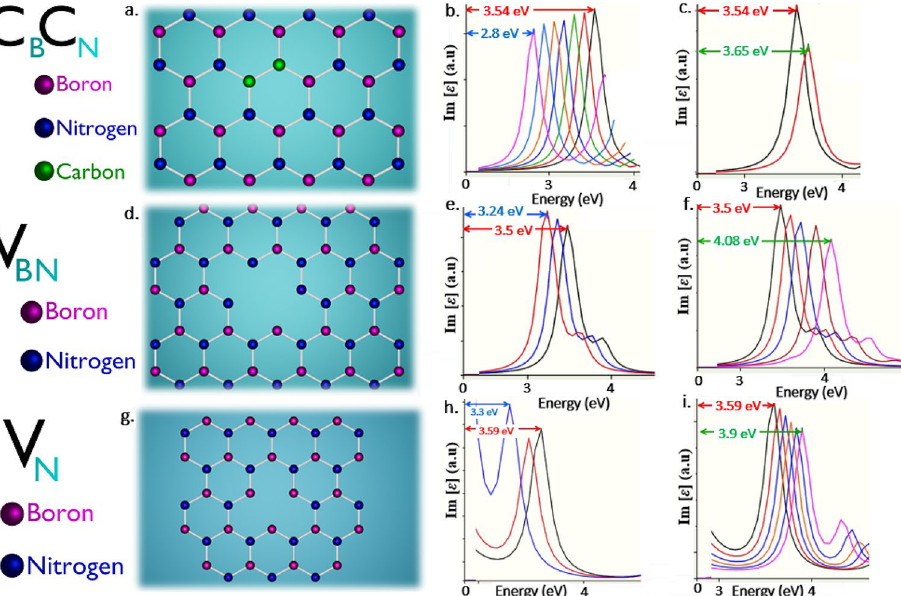
Figure 12. Schematic illustration of DFT computed C B C N , V BN and V N defects and their corresponding tunable quantum emission towards lower and higher energy regions. ( a , d , g ) Schematic illustration of C B C N (carbon dimer), V BN (boron and nitrogen di-vacancy) and V N (nitrogen mono vacancy) defects whose ZPL energies are observed at 3.54 eV, 3.5 eV and 3.59 eV respectively and corresponding tunable quantum emission towards lower and higher energy region for biaxial strains as described in Tables 3 and 4. ( b , e , h ) Tunability of defects towards lower energy region. ( c , f , i ) Tunability of defects towards higher energy region. All red colour arrows indicate ZPL energy under no strain. All blue colour and green colour arrows indicate tuned ZPL energies towards lower energy regions and higher energy regions respectively. The corresponding PDOS information of unstrained and strained quantum emitters were provided in Figure S4 (supporting